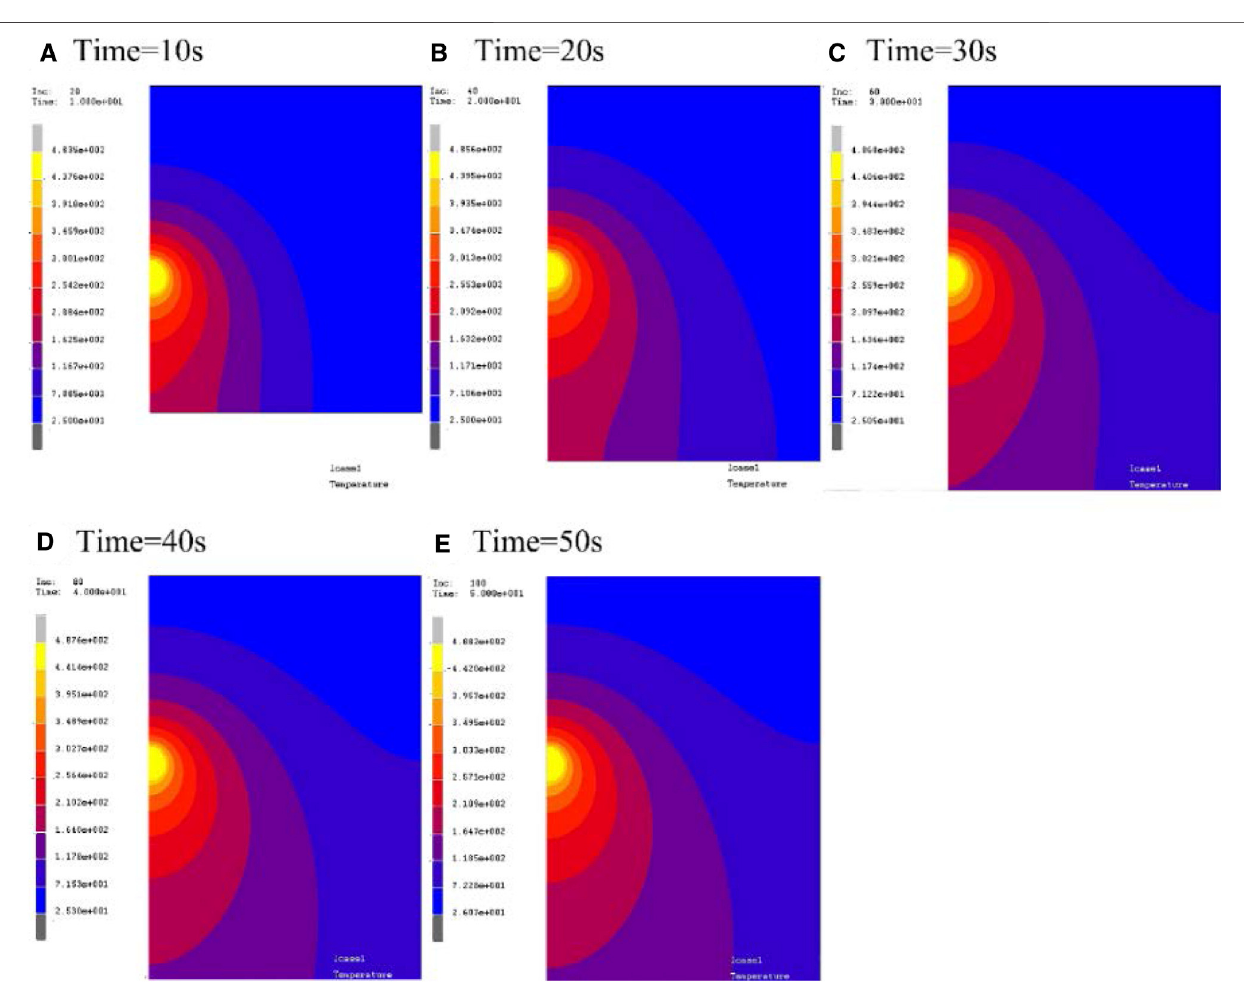
Frontiers in Materials |